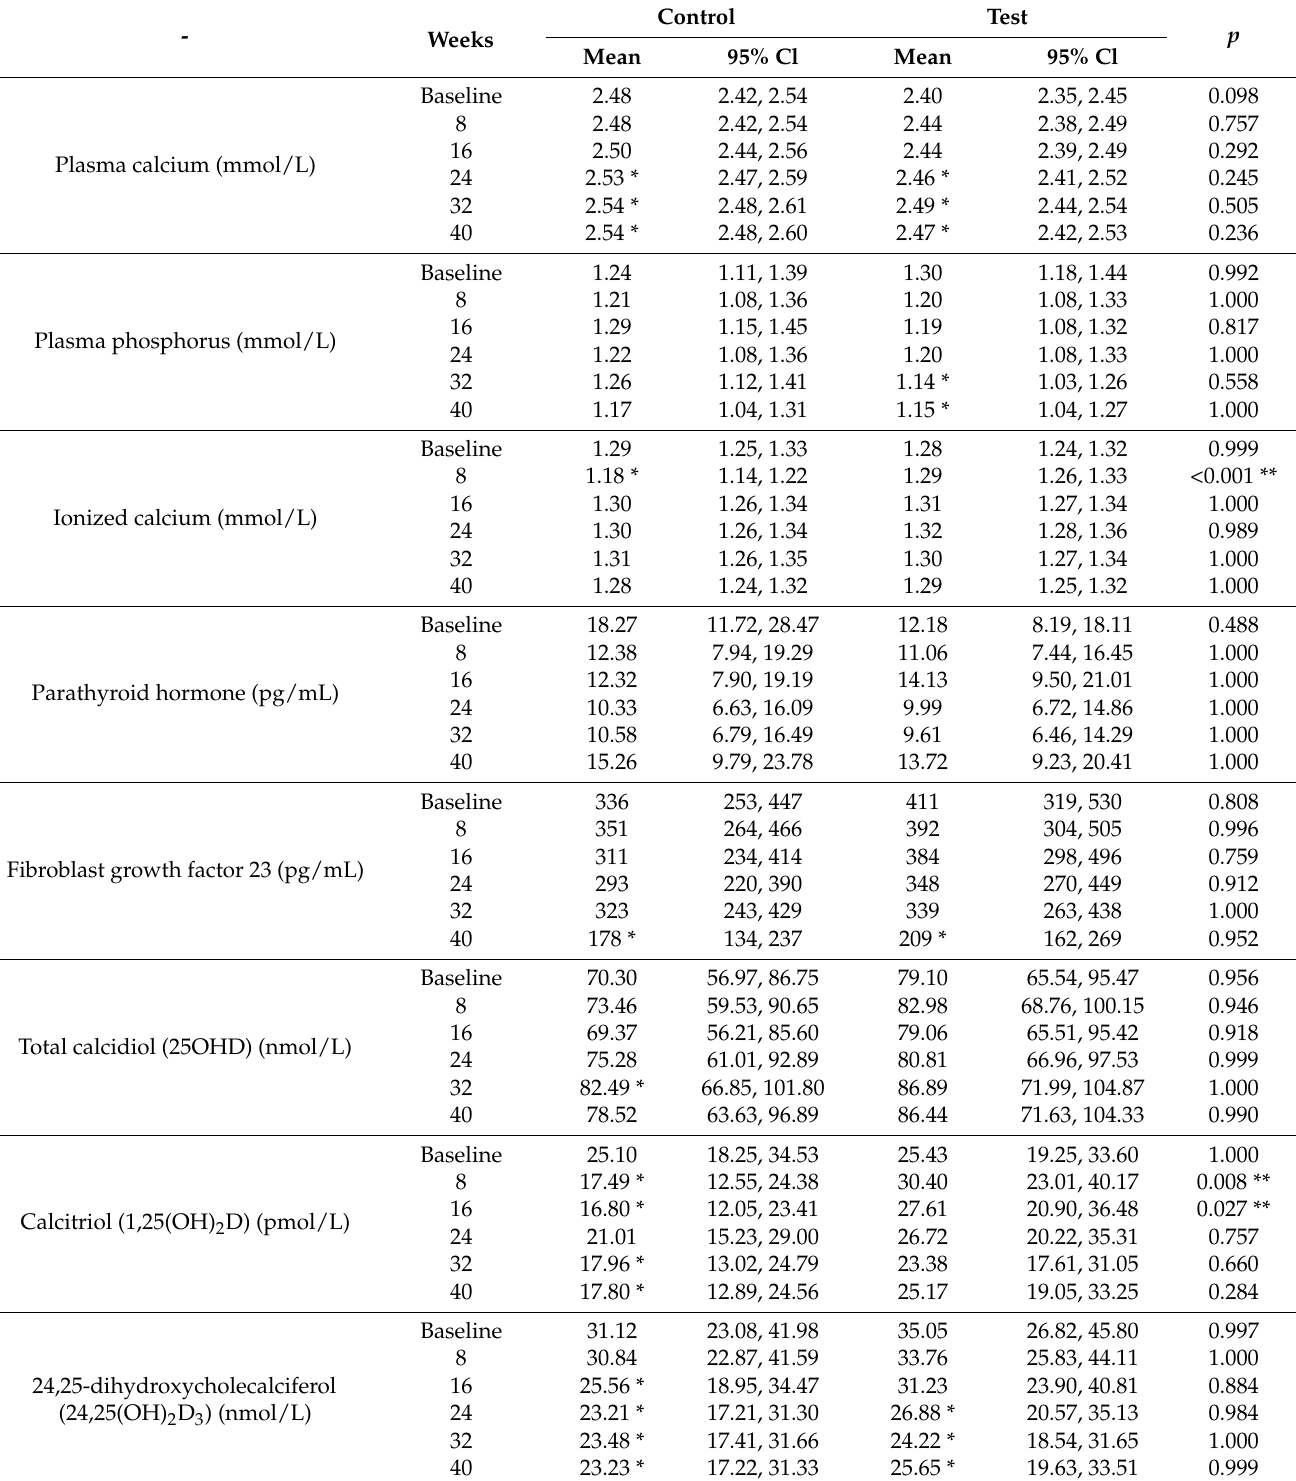
Table 3. Calcium, phosphorous, and related regulatory hormones and metabolite values measured in blood given as the means and 95% confidence intervals (CI) for the control ( n = 8) and test ( n = 10) diet dog groups at the baseline and at eight-week intervals. P values represent the comparison between diet groups at the sample collection time